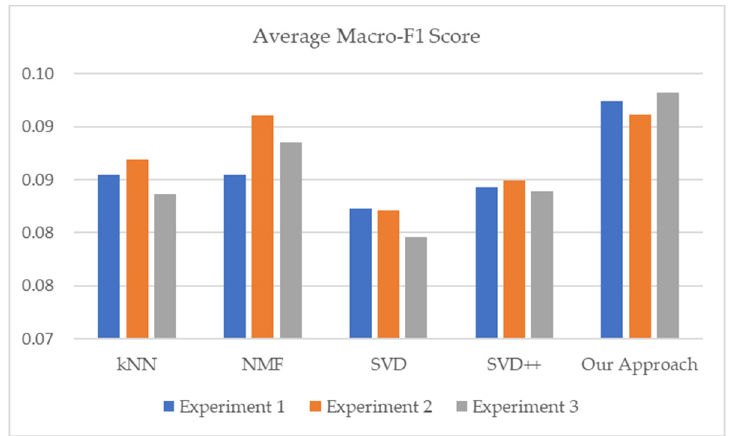
Figure 21. Average accuracy comparison of our proposed approach with the other approaches.